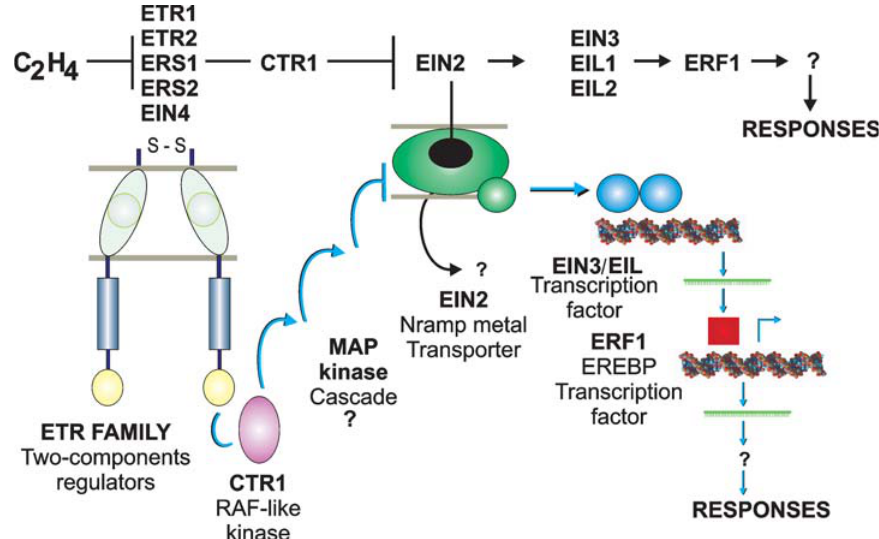
Figure 2 - Genetic interactions and biochemical identities of the ethylene signal transduction pathway components (from Bleecker and Kende,